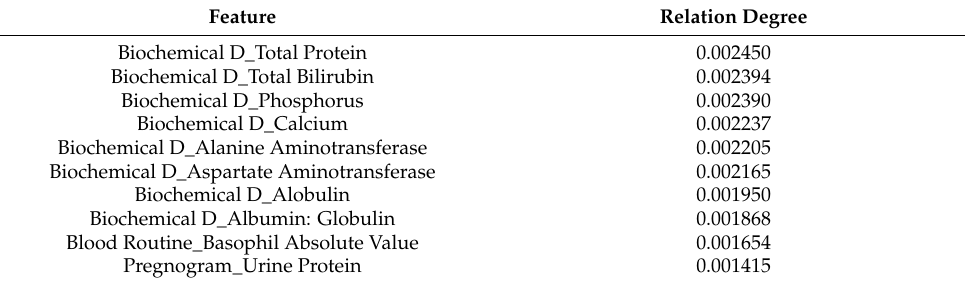
Table 3. Bottom 10 features of